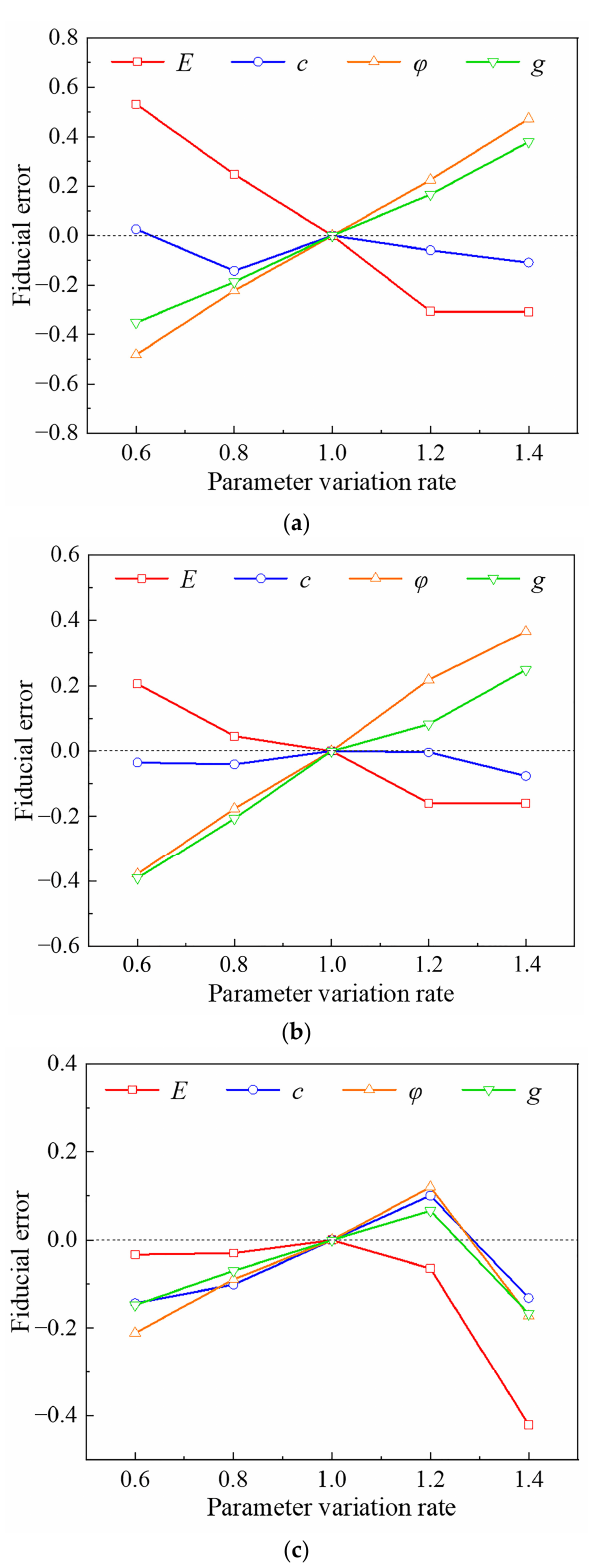
Figure 9. Key unit dynamic shear reference value error curve. ( a ) A1; ( b ) B1; ( c ) B2.